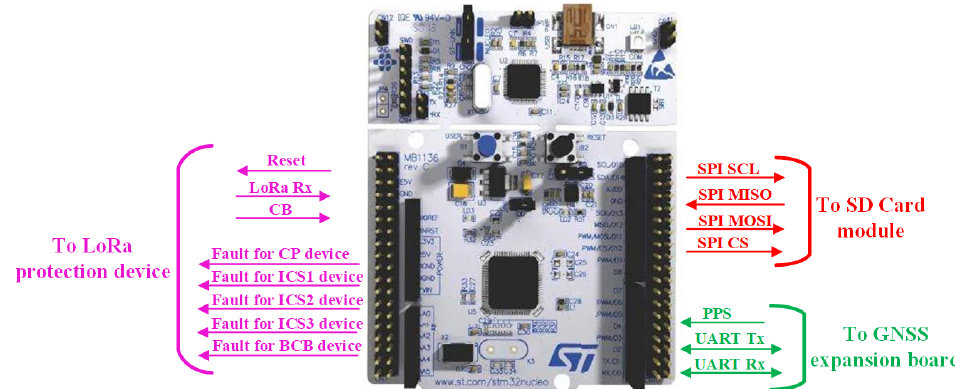
Figure 6. Connection between the control board and the other components of the node. Figure 7 shows the protection device with the controller node assembled.